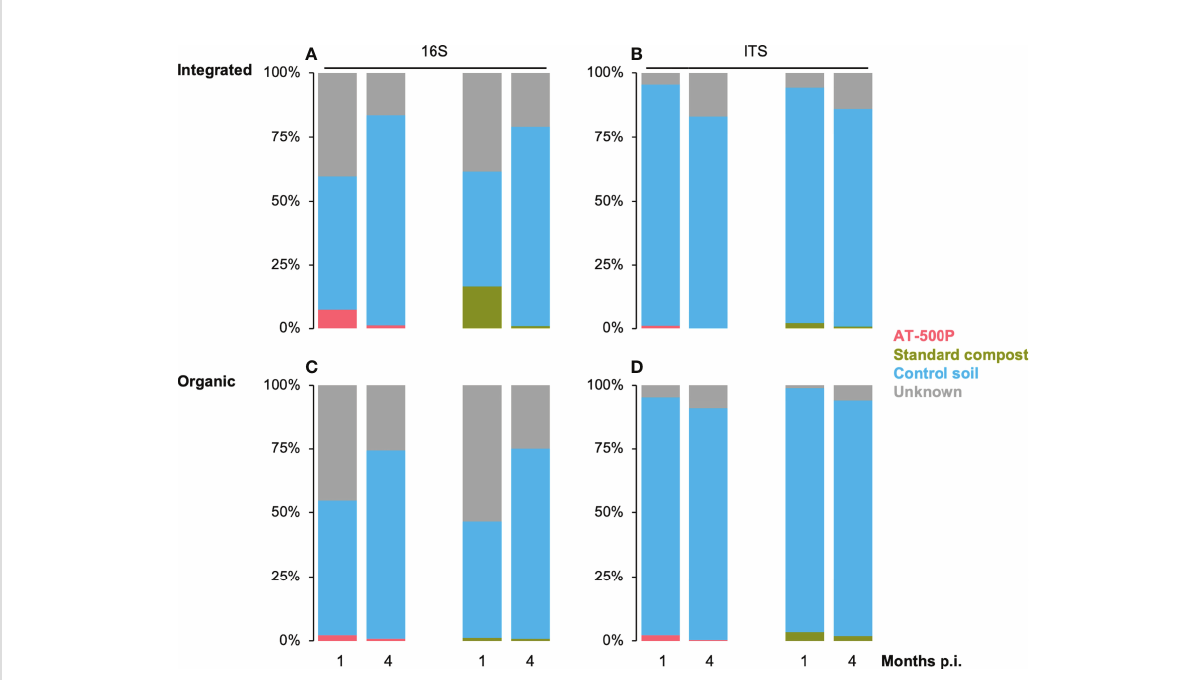
FIGURE 5 Tracking the microbiome transfers from standard compost and BD manure (AT-500P) extracts (i.e. microbiome source) into the treated rhizosphere soil under different management systems and sampling times. Panel (A) and (B) shows the proportion of microbiota tracked from treatment into rhizosphere in the integrated orchard for bacterial and fungal community, respectively, while (C) and (D) represent the same for the organic orchard. The proportion of the microbiome in the treated rhizosphere which was shared with the untreated soil (i.e. control soil) is shown both for organic and integrated orchards. The unknown part of the microbiome includes the percentage proportion of microbiota in treatments which could not be traced in the rhizosphere. Coloured stacked bars represent proportions of microbiome in treated rhizosphere (i.e. AT-500P and standard compost extracts), shared microbiome between control and treated rhizosphere soil, as well as the unknown microbiome (i.e. the unassigned part of treatment microbiome). The x-axis represents time in months post inoculation. The y-axis shows the proportion of the community originating from the different